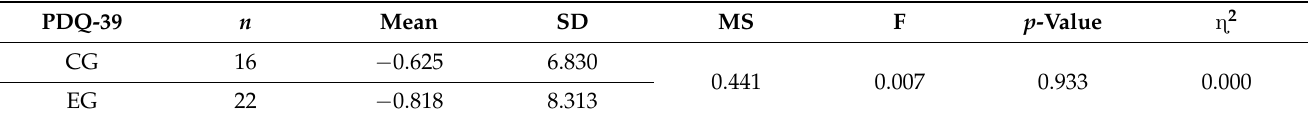
Table 6. Inter-group comparison of PDQ-39 differential score between pre-test and post-test.